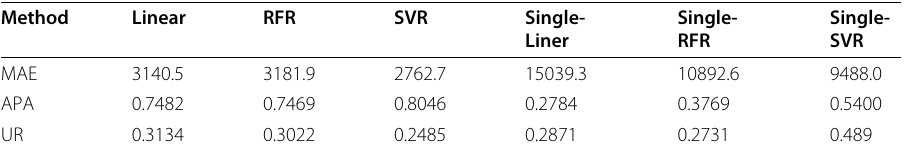
Table 5 Predicting results of six